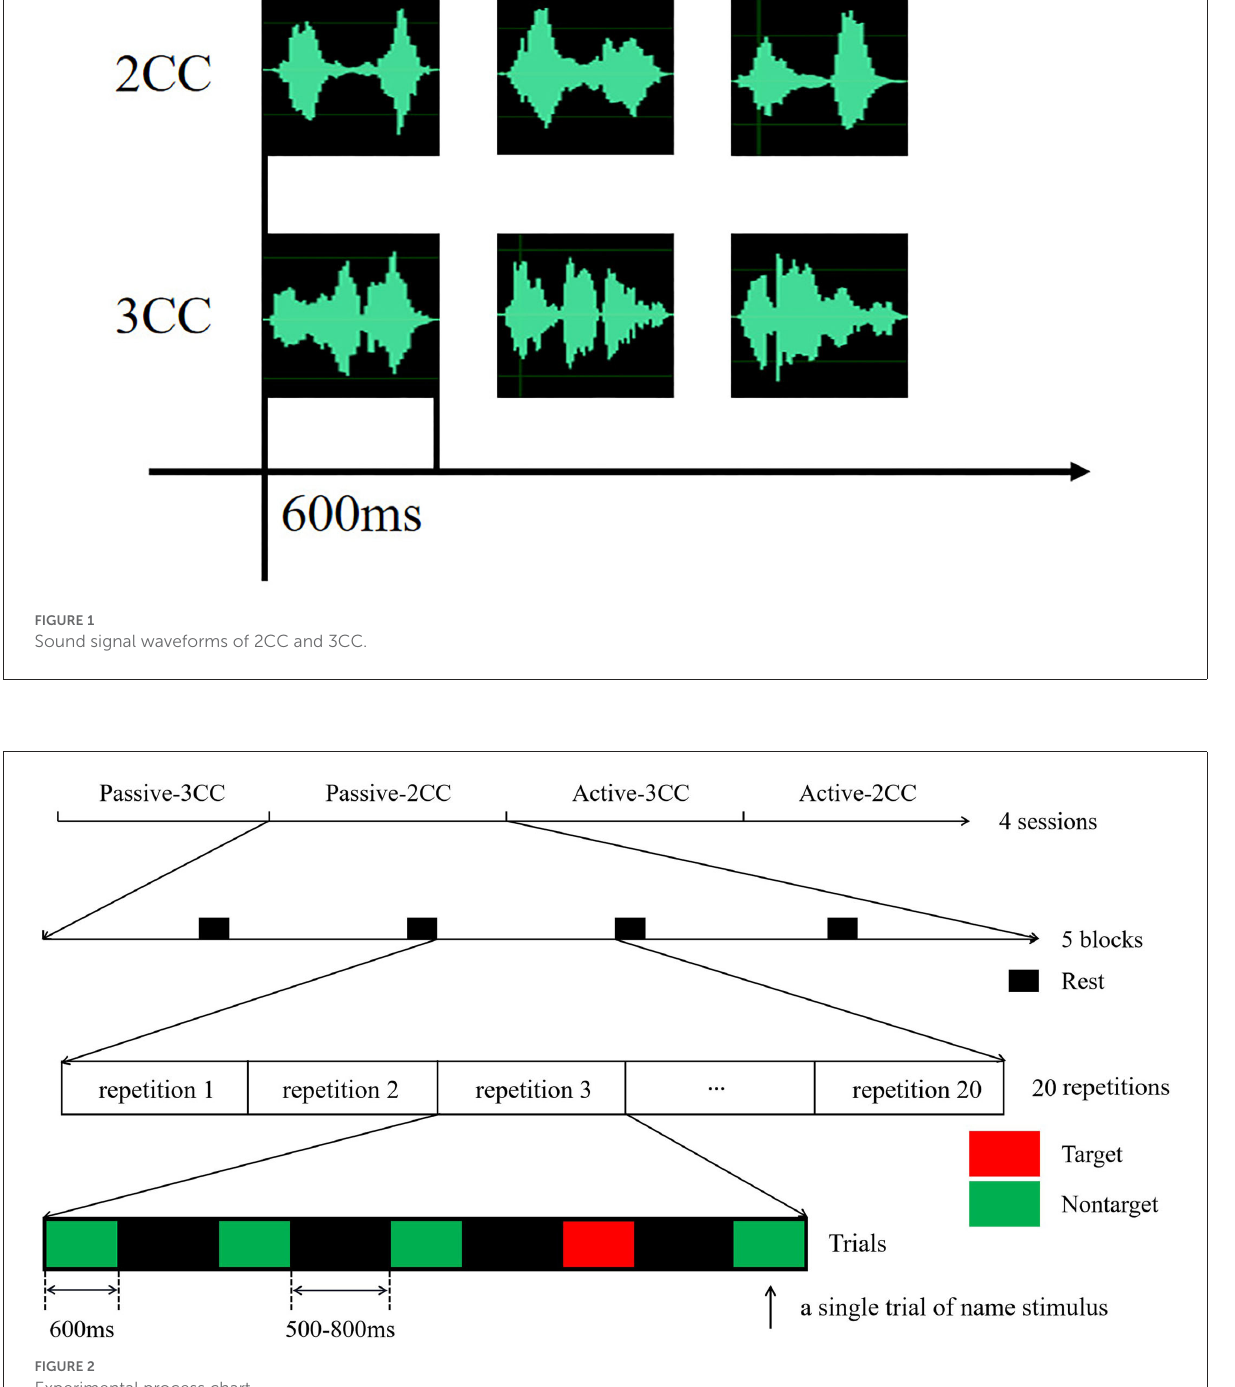
FIGURE2 Experimental process